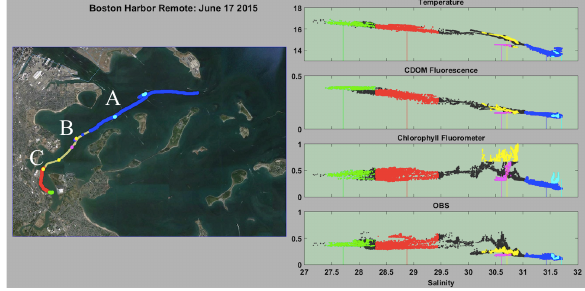
Figure 1. The cruise track along which in-situ data was collected under Landsat-8 overpass. The measured data are provided as a function of salinity along the transect. The buoys A, B, and C have been